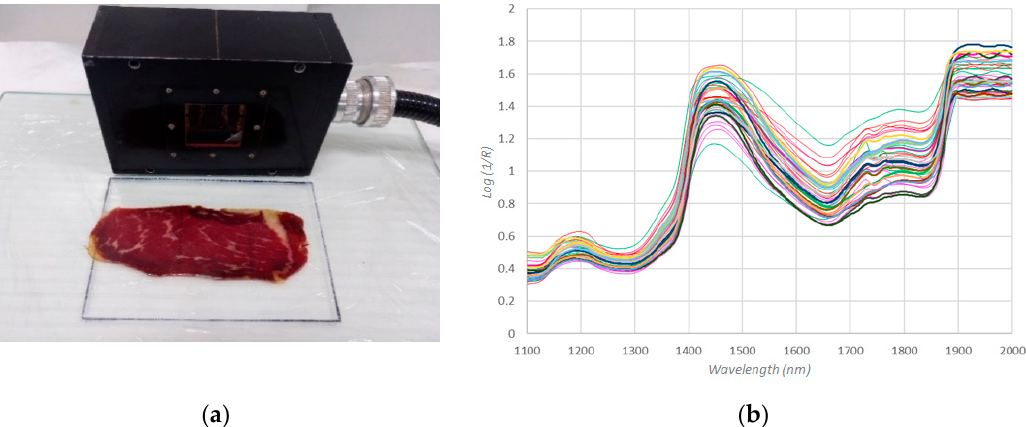
Figure 1. Near infrared (NIR) measurements: ( a ) a record of NIR Spectra; ( b ) spectra of the cecina samples.